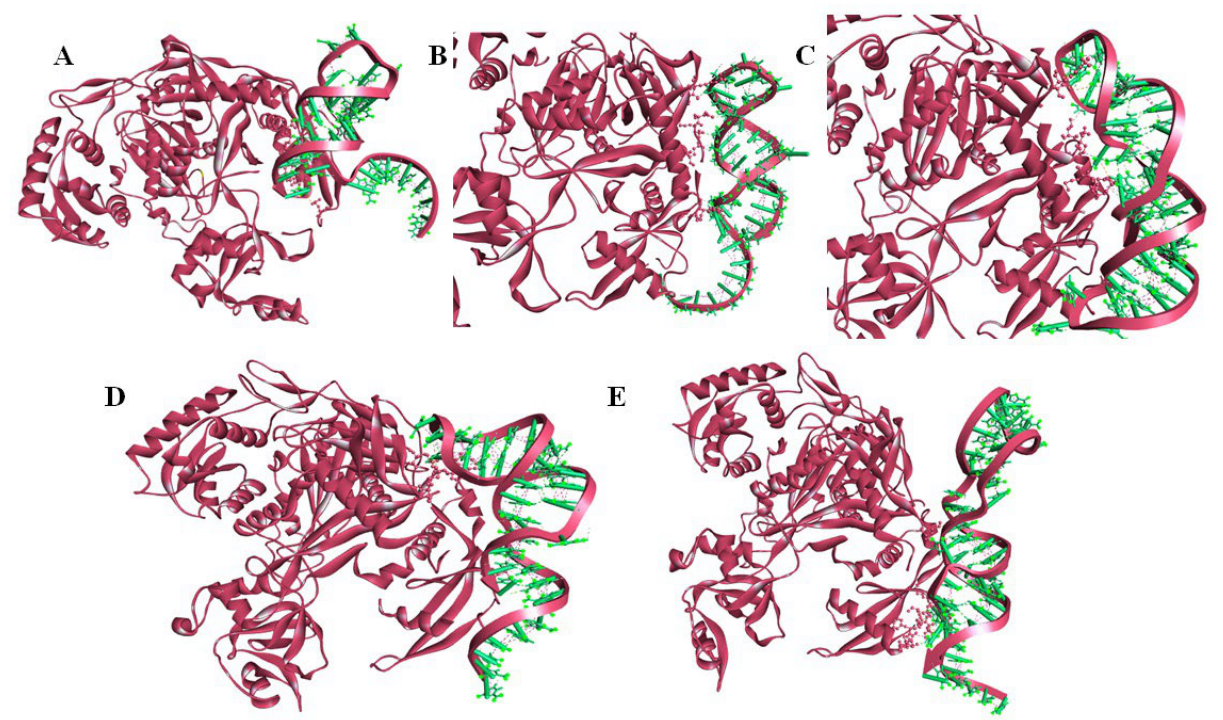
Figure 9. Molecular Docking of mRNA–miRNA duplexes and AGO protein; ( A ) miR-122–PIK3CG– AGO complex; ( B ) miR-122–RHOA–AGO complex; ( C ) miR-122–SMAD4–AGO complex; ( D ) miR122– PTPN1–AGO complex; ( E ) miR-122–MTDH–AGO